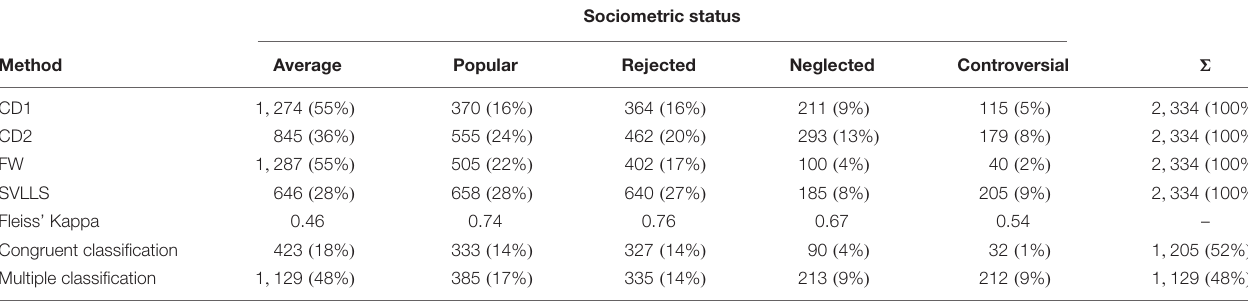
TABLE 1 | Number of students classified into sociometric status groups by different sociometric status classification